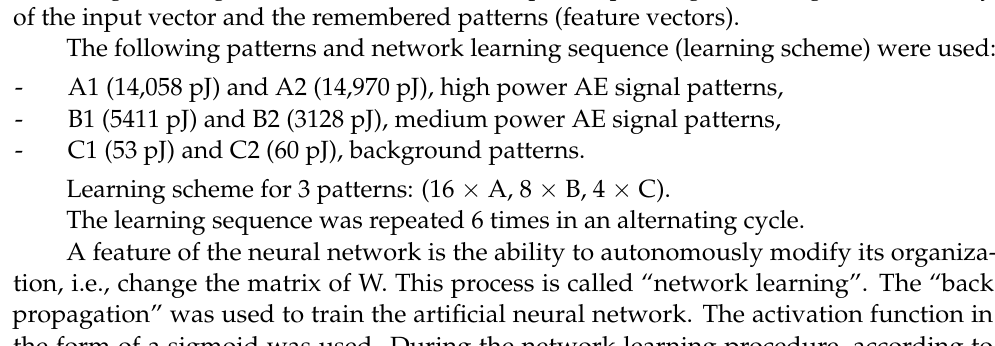
Figure 5. A simplified diagram of the neural network used in the research. A signal was generated at the network outputs depending on the degree of similarity of the input vector and the remembered patterns (feature